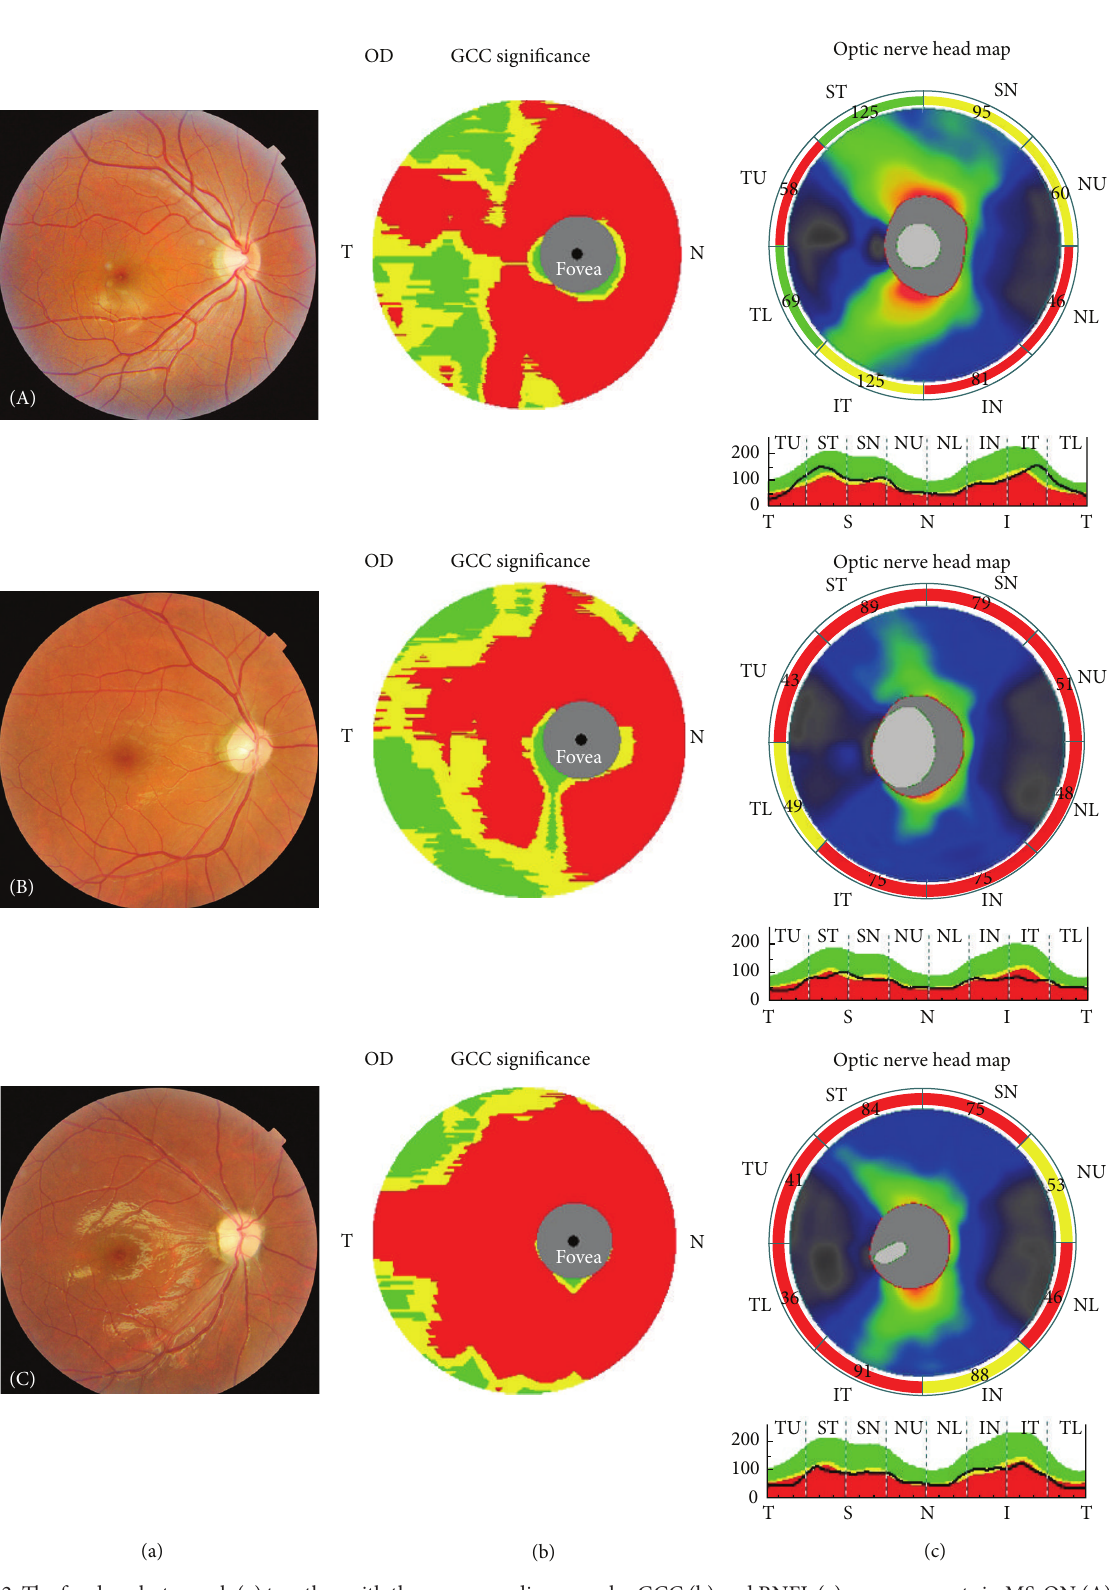
Figure 2: The fundus photograph (a) together with the corresponding macular GCC (b) and RNFL (c) measurements in MS-ON (A), R-ON (B), and NMO-ON (C) groups are showed,